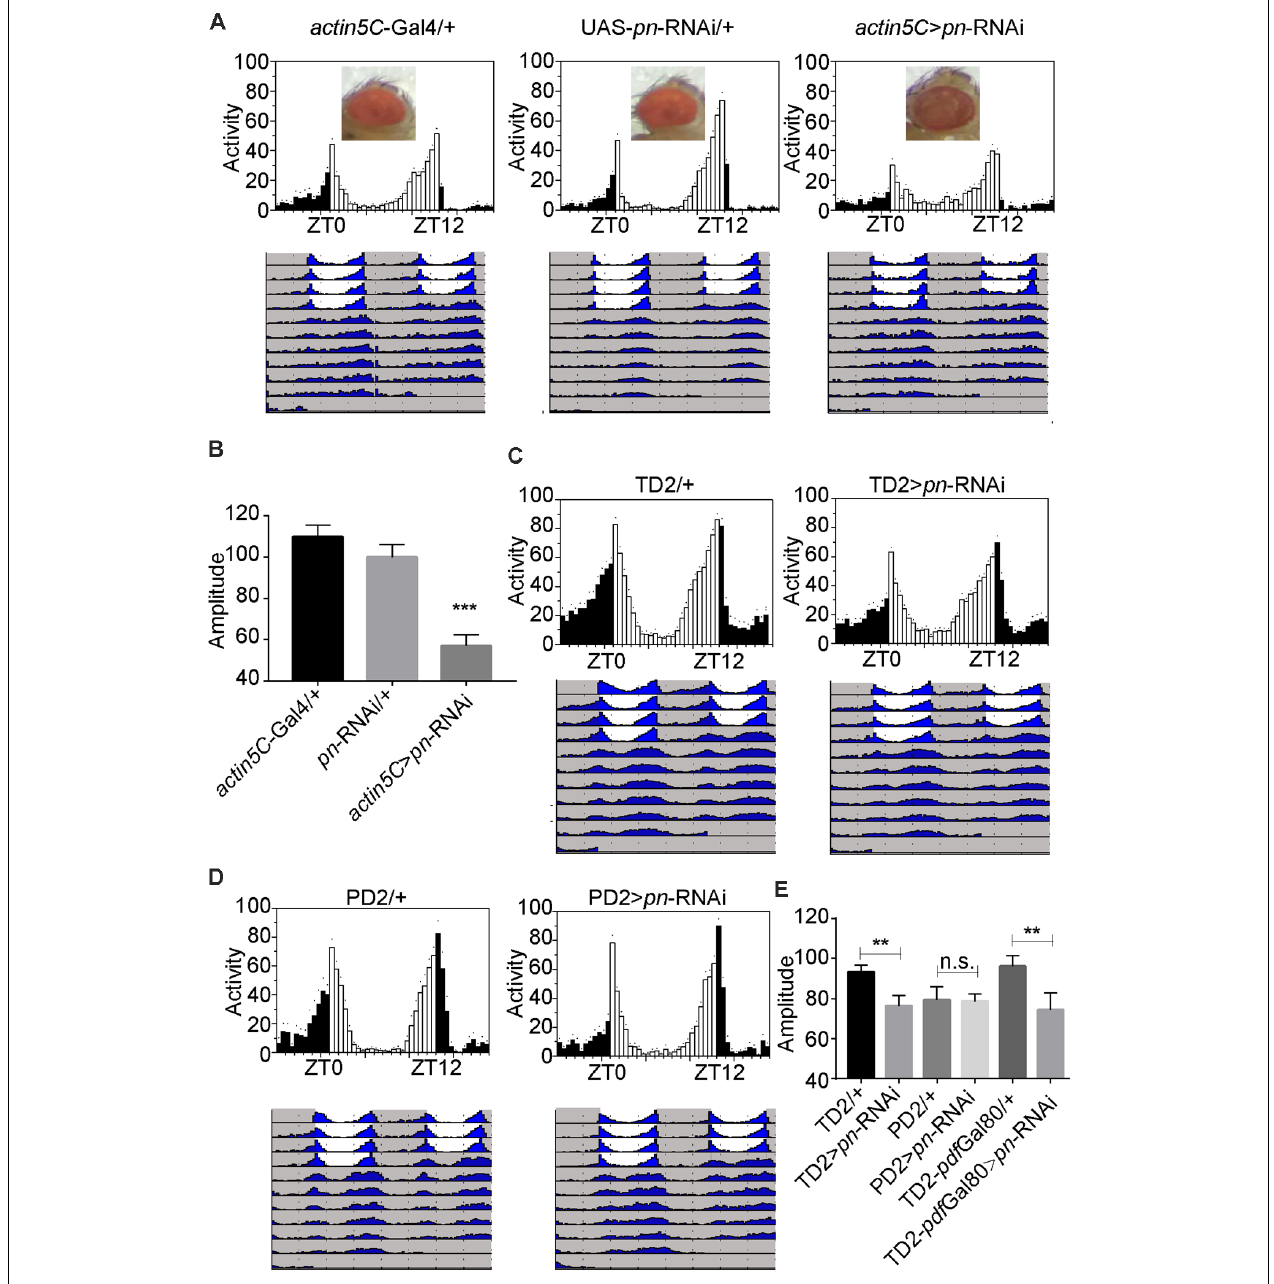
FIGURE 3 | Pn expression in circadian tissues affects the robustness of circadian rhythm. (A) Averaged activity profiles and actograms of control flies and actin5C > pn -RNA interference (RNAi) flies. (B) Amplitudes of circadian rhythms in control flies and actin5C > pn -RNAi flies. (C–E) Averaged activity profiles, actograms and amplitudes of control flies and flies in which pn expression was inhibited by expression of shRNA with different circadian neuron-specific drivers. TD2 indicates tim -Gal4, UAS- Dicer2 . PD2 indicates pdf -Gal4, UAS- Dicer2 . White bars represent day, black bars represent night, ZT is indicated on the x axes. The dots above the bars indicate SEM. The period and amplitude are shown as means ± SEM ( n = 33–50). At least three independent repeats were performed. ∗∗ P < 0.01, ∗∗∗ P < 0.001, n.s. no